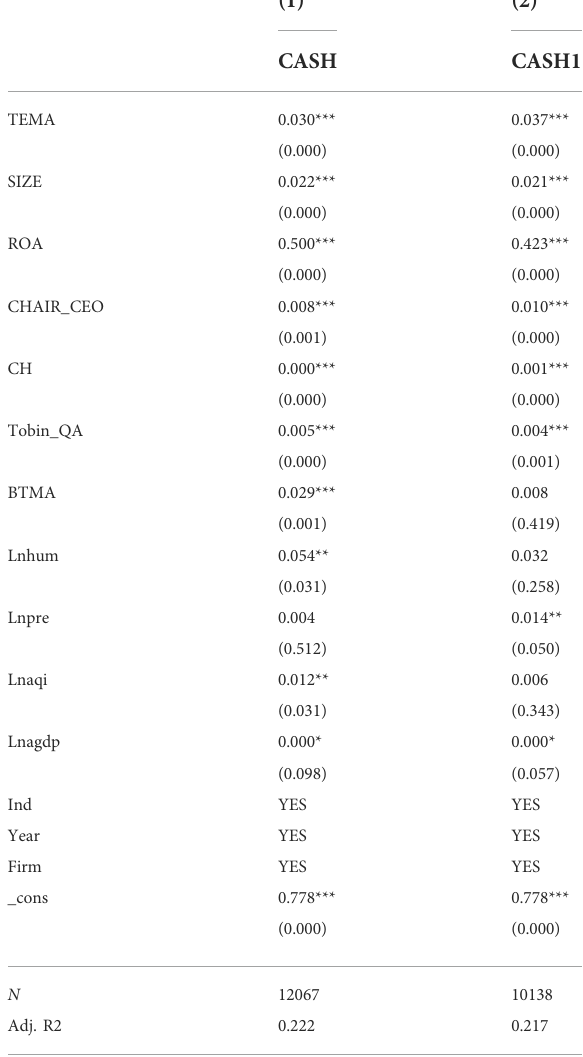
TABLE 7 Regression results after sample